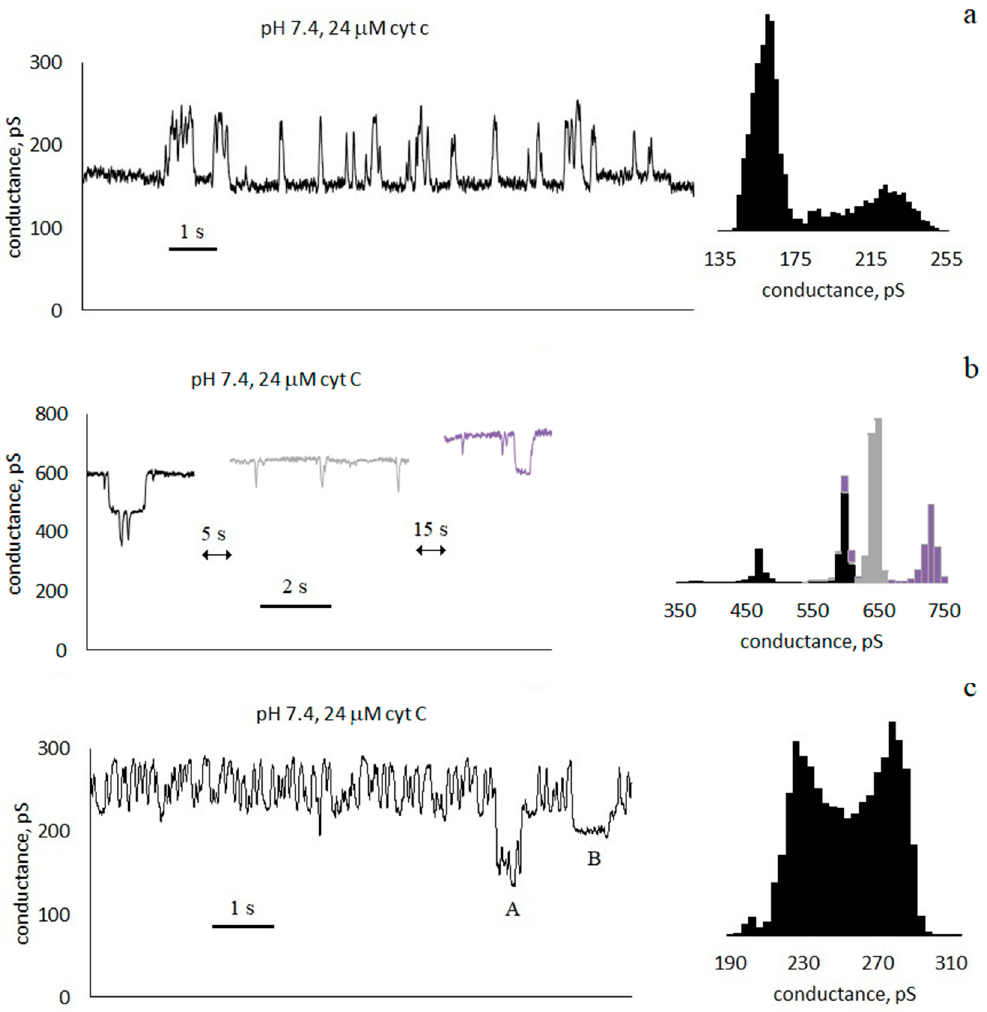
Figure 3. Conductance traces and histograms of asolectin membranes with symmetrical 24 µM addition of cyt c at pH 7.4: ( a – c ) are three different membranes; 0.1 M KCl, 20 ms averaging.